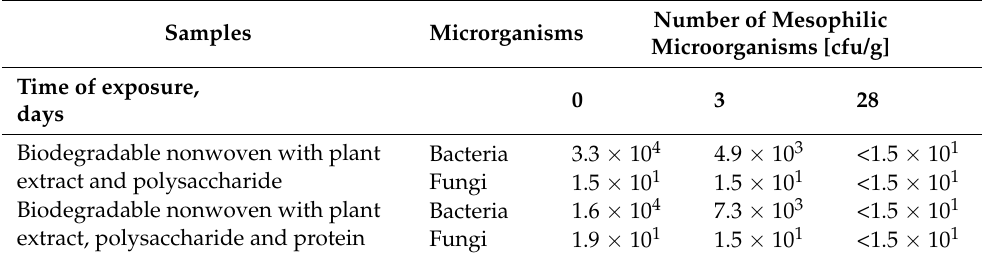
Table 2. Antipathogenic effect of plant extract and natural substance on spun-bonded biodegrad- able